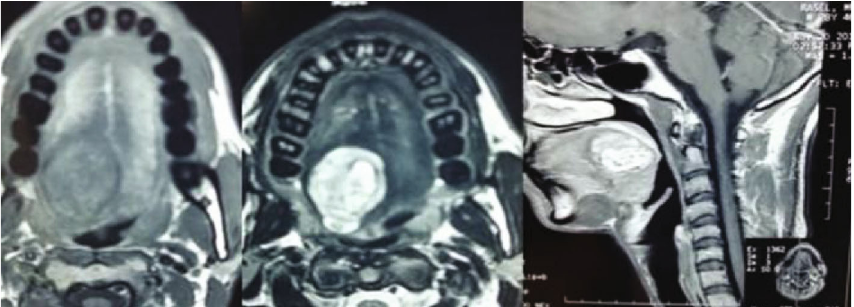
Figure 2: Axial T1 and T2 and sagittal T1-weighted magnetic resonance image showing a well-de fi ned mass centered right to the midline in the base of the tongue. The tumor has a smooth well-de fi ned border, with no invasion.